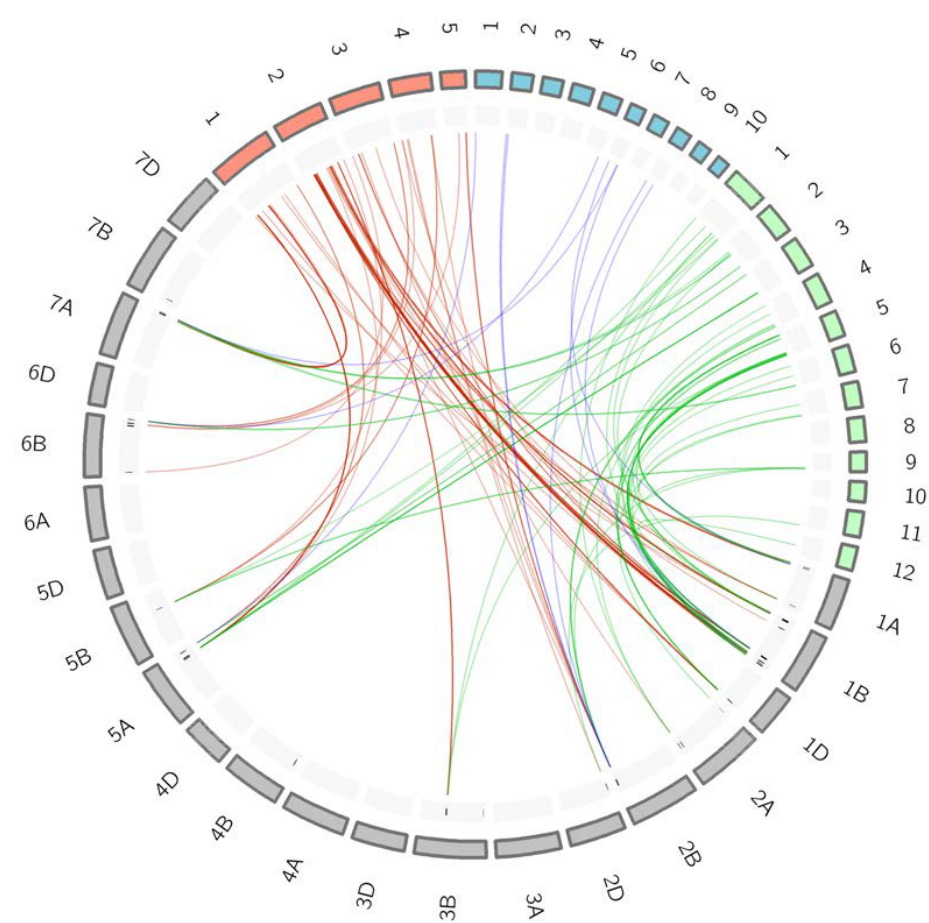
Figure 5. Synteny among genomes for the selected QTL hotspots. For better visualization of the chromosome links, the size of the Brachypodium and rice chromosomes is multiplied by 10. Colour code: red, Brachypodium ; blue, maize; green, rice; grey, wheat.